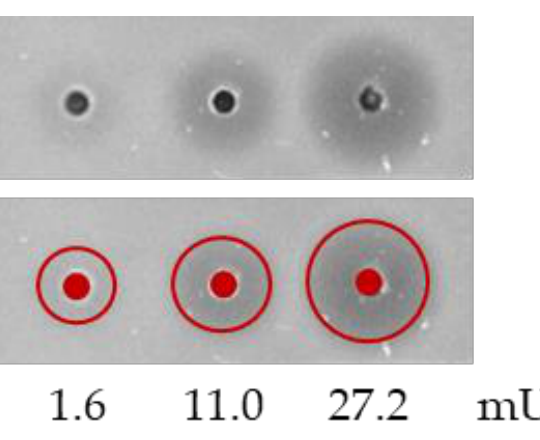
Figure A3. Age distribution. Abbreviations: CA: cardiac arrest.